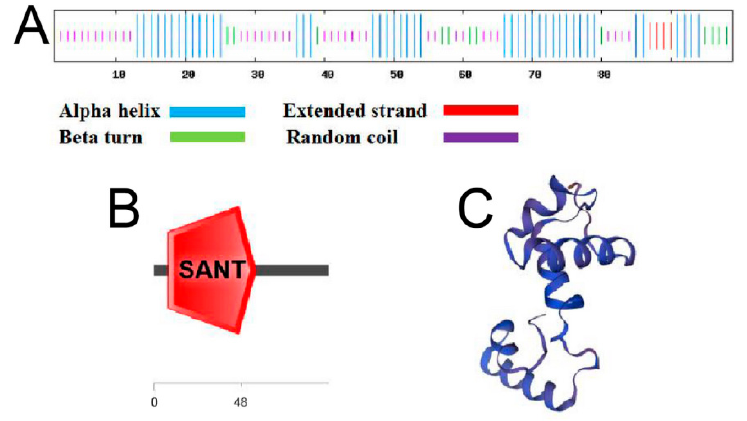
Figure 2. Structure and domains of predicted FvMYB114 protein. ( A ) Secondary structure; ( B ) protein domains; ( C ) tertiary structure of FvMYB114 protein.